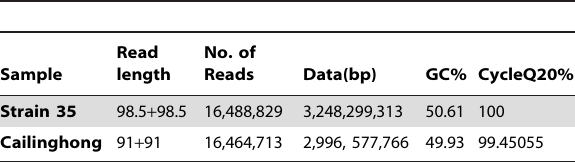
Table 1. Summary of transcriptome sequencing for Sal via splendens .